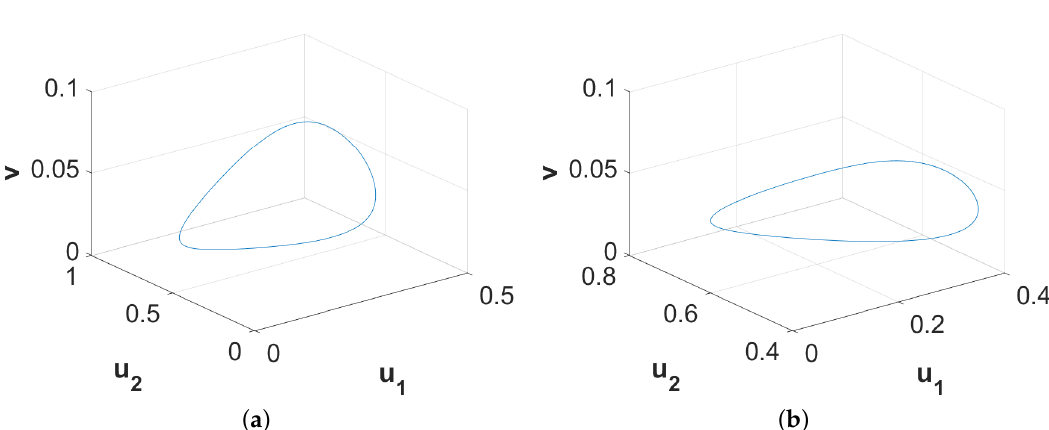
Figure 6. Phase diagrams of spatial average densities of the associated three species corresponding to ( a ) Figure 5a, ( b ) Figure 5b.